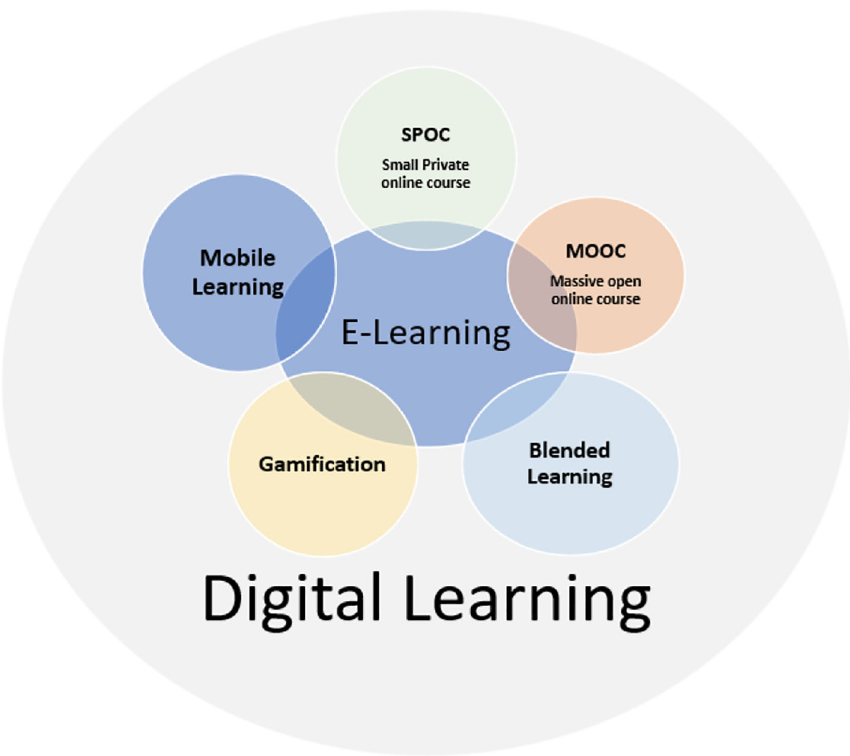
Figure 2. Relationship between e-learning (electronic learning), m-learning (mobile learning), and d-learning (digital